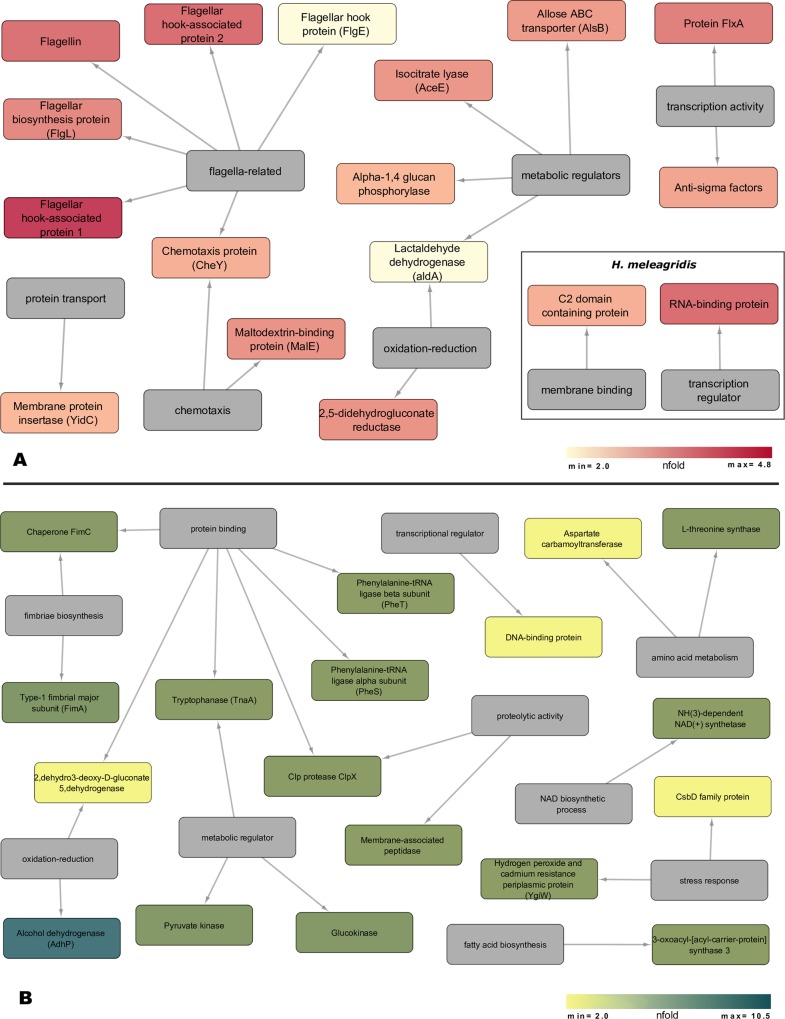
Protein function network of up-regulated proteins detected by the SWATH-MS approach (≥ 2-fold and p-value < 0.05).(A) H. meleagridis virulent exoproteome, (B) H. meleagridis attenuated exoproteome. The source nodes are categorized according to biological process of the proteins. The colour-coding is based on the n-fold over-expression data associated with each significantly differentially expressed protein (Tables 1 and 2). The network layout was manually determined. Over expressed proteins in virulent histomonads (A) are displayed in small inserted figure.